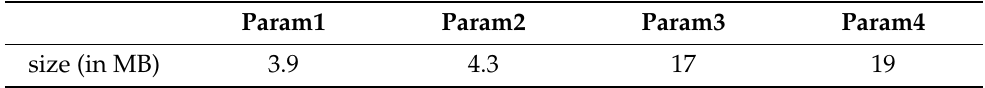
Table 8. Size of a single (compressed) ciphertext.